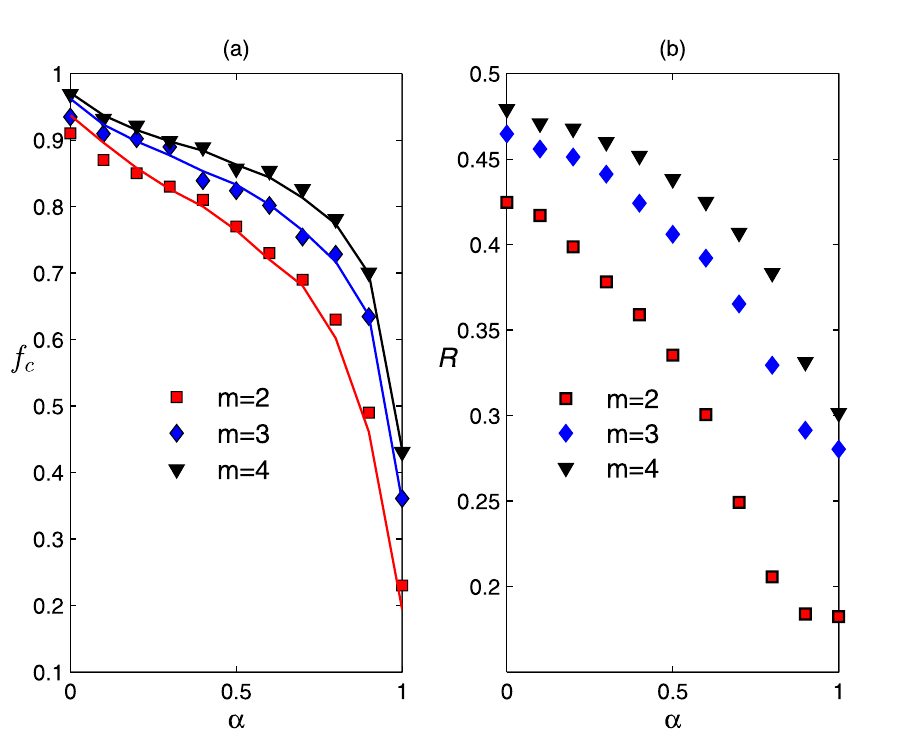
Figure 4. The critical removal fraction of nodes f c ( a ) and network robustness R ( b ) versus attack information perfection parameter α in random scale-free networks. The degree distributions follow p d ( k ) = ( λ − 1) m λ − 1 k − λ , where N = 1000, λ = 2.5, m = 2 ( ■ ), m = 3 ( ◆ ) and m = 4 ( ▼ ). The simulation results are averaged over 100 independent realizations of imperfect attack information. The solid lines correspond to the analytical